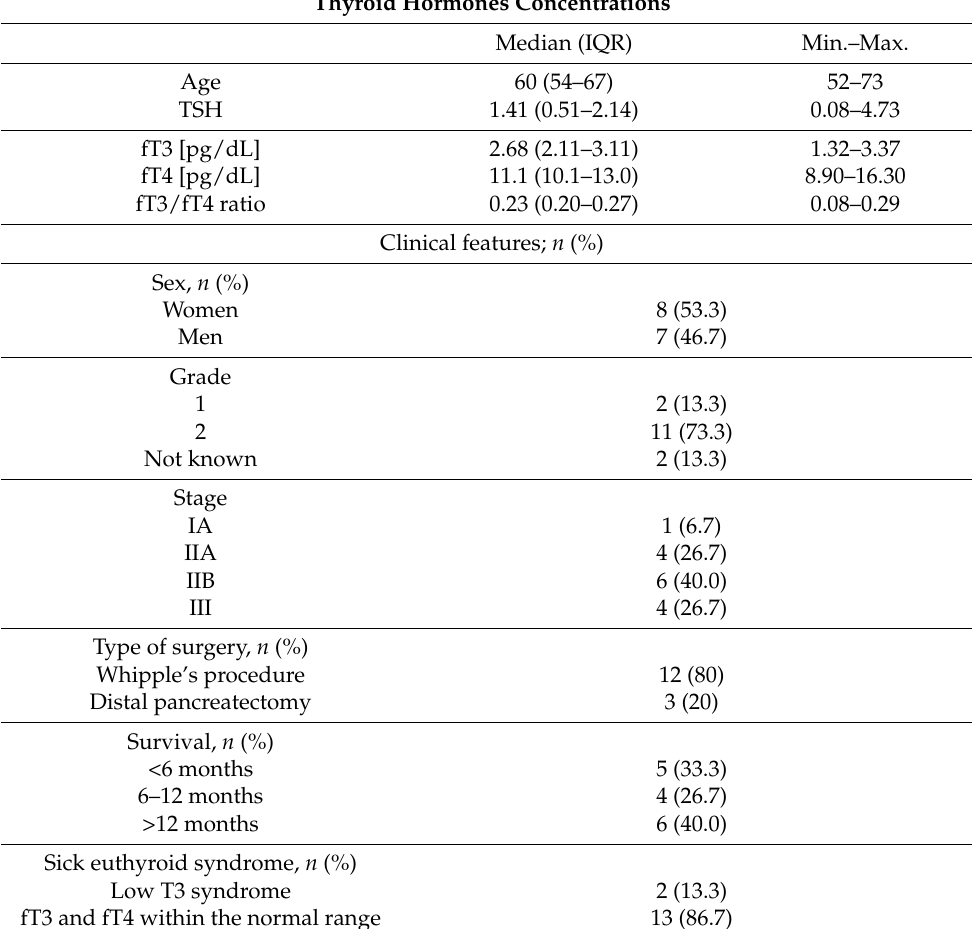
Table 1. General patient